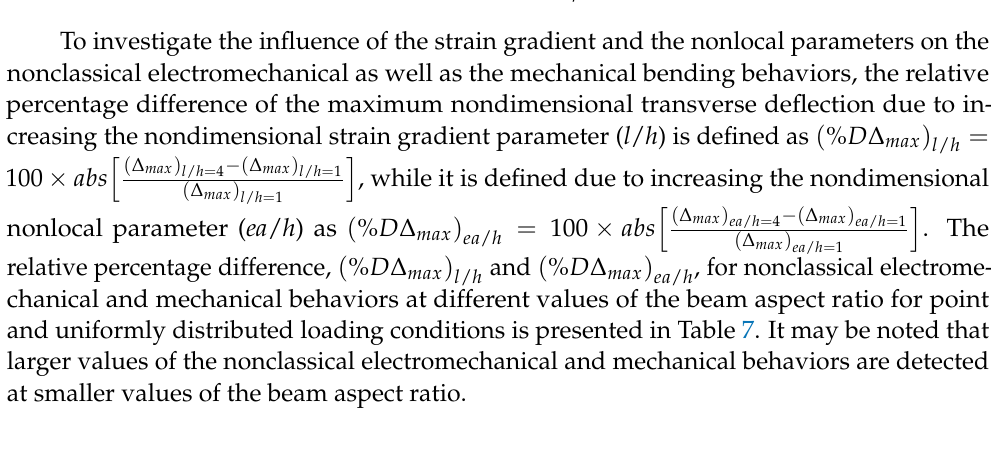
Table 7. The relative percentage difference in the transverse deflection due to increasing the nondi- mensional strain gradient parameter ( l / h ), (%𝐷∆ (cid:3040)(cid:3028)(cid:3051) ) (cid:3039)/(cid:3035) , and the nondimensional nonlocal param- eter ( ea / h ), (%𝐷∆ (cid:3040)(cid:3028)(cid:3051) ) (cid:3032)(cid:3028)/(cid:3035) , for electromechanical and mechanical nonclassical behaviors under point and uniformly distributed loads at beam aspect ratio L / h = 10, 20, e 311 = -4.1 C/m 2 , μ 3111 = 5 × 10 − 8 C/m, a 33 = 7.124 × 10 − 9 C/m 2 K, K w = 50, K p = 5, α = 0.5, and N = 4.